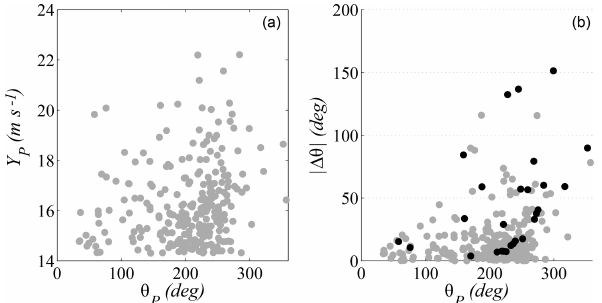
Figure 3. (a) Directional variability in the peak velocities of storm events. (b) Variability in the angular distance traveled by each